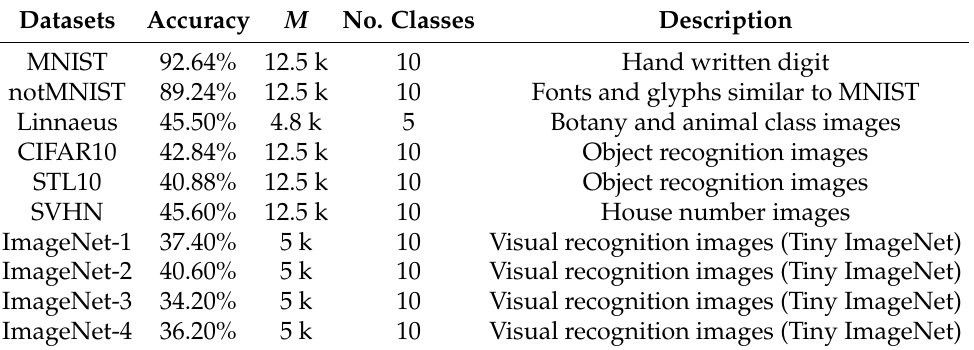
Table 1. Details of the datasets used in our experiments. The accuracy is from MLP-2, and M represents the total number of data used for training and